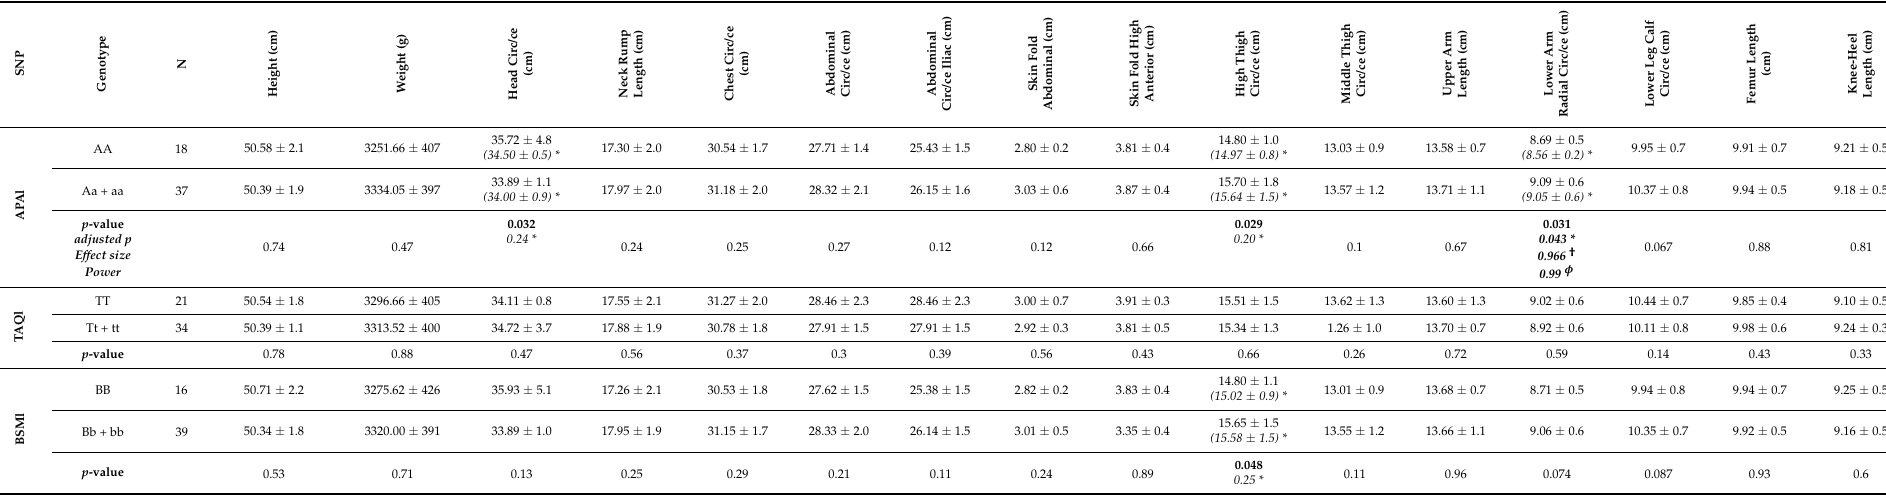
Table 8. Birth neonatal anthropometry (maternal vitamin D status at birth <75 nmol/L) according to neonatal VDR